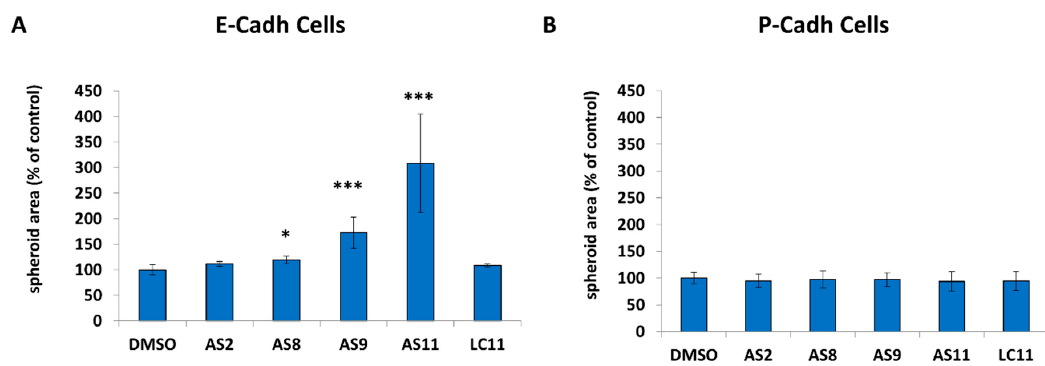
Figure 4. Both AS11 and AS9 target E-cadherin. BxPC-3 E-cadh cells (P-cadherin depletion) ( A ) and BxPC-3 P-cadh cells (E-cadherin depletion) ( B ) were incubated in the presence of 0.05 mM (E-cadh cells) or 0.1 mM (P-cadh cells) AS2, AS8, AS9, AS11, or LC11 and allowed to aggregate in suspension for 24 h. The spheroid area was measured by phase-contrast microscopy and analyzed by ImageJ. A p < 0.05 was considered statistically significant and is indicated by ‘***’ when p < 0.001 and ‘*’ when p < 0.05. See the Materials and Methods section for details on the statistical analysis.